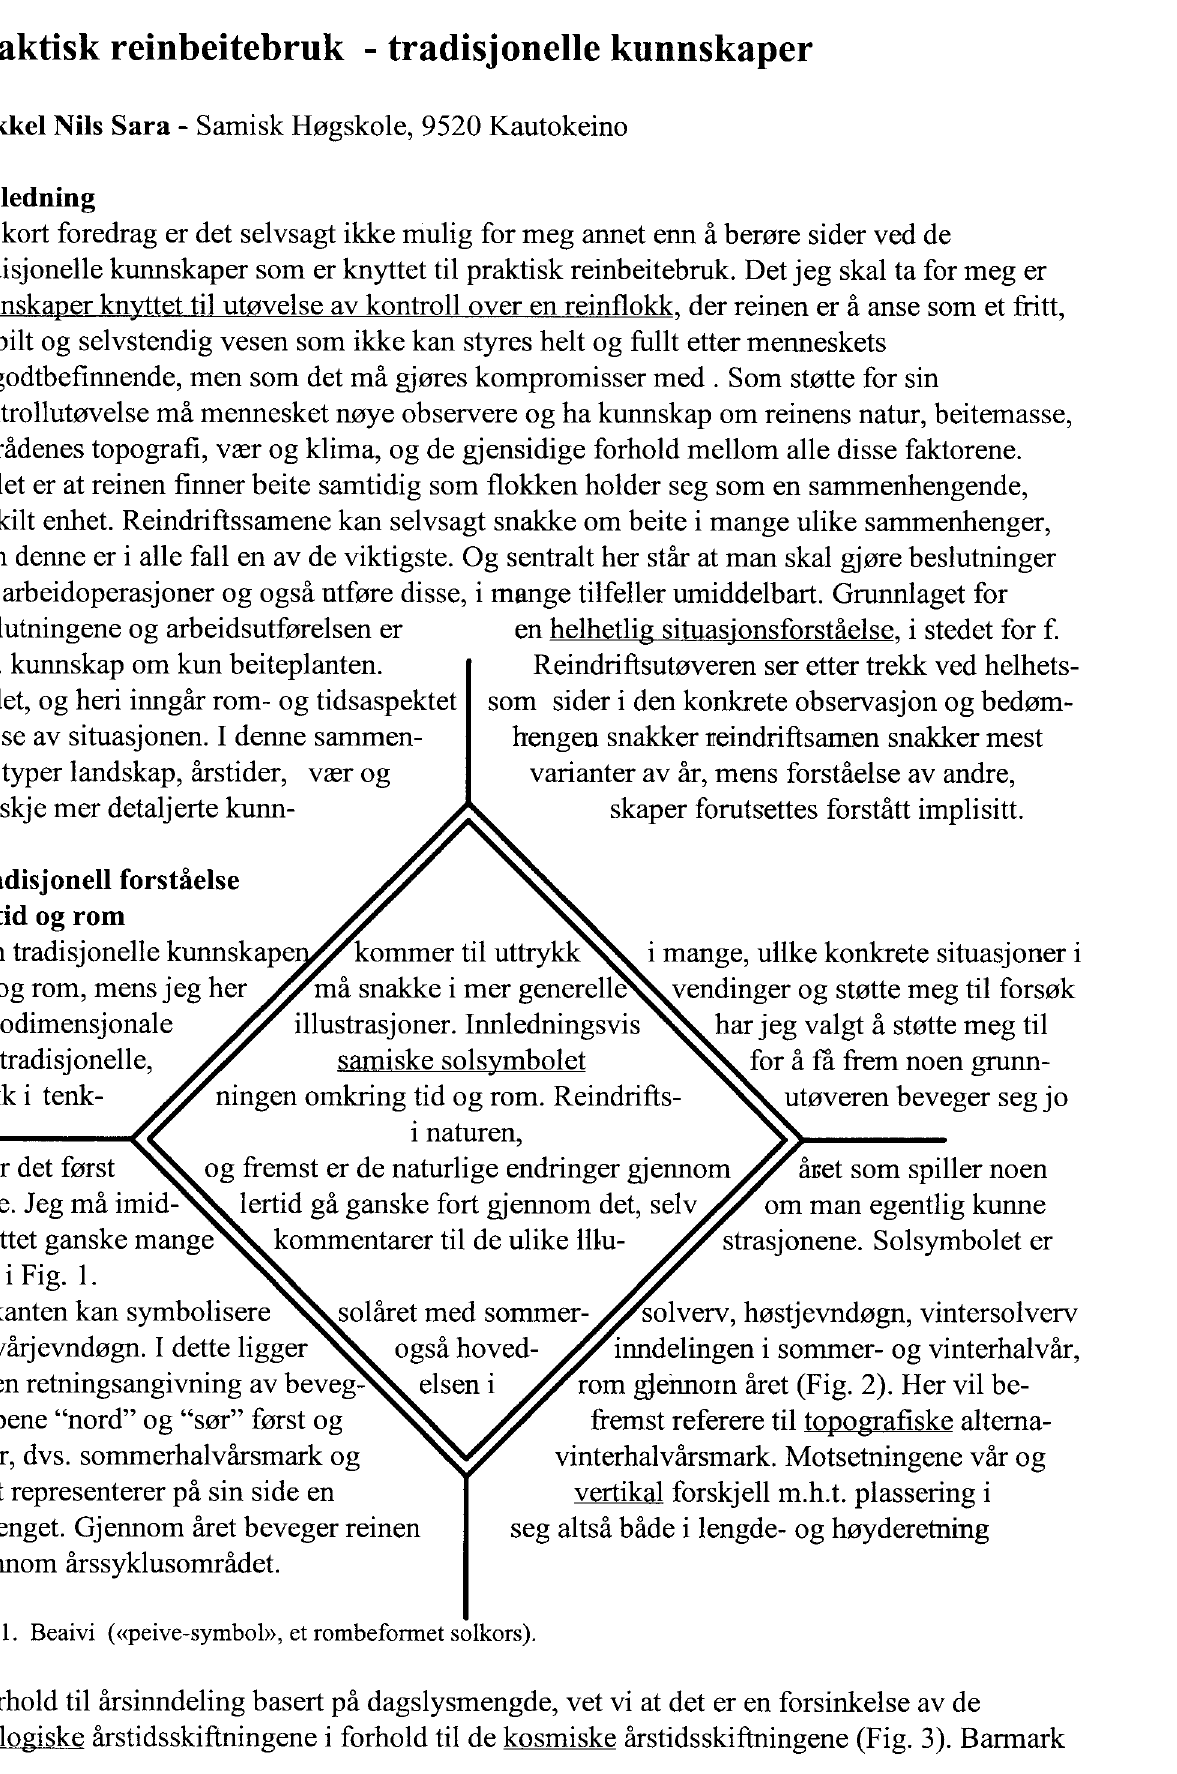
Fig. 1. Beaivi («peive-symbol», et rombeformet solkors). I forhold til årsinndeling basert på dagslysmengde, vet vi at det er en forsinkelse av de økologiske årstidsskiftningene i forhold til de kosmiske årstidsskiftningene (Fig. 3).